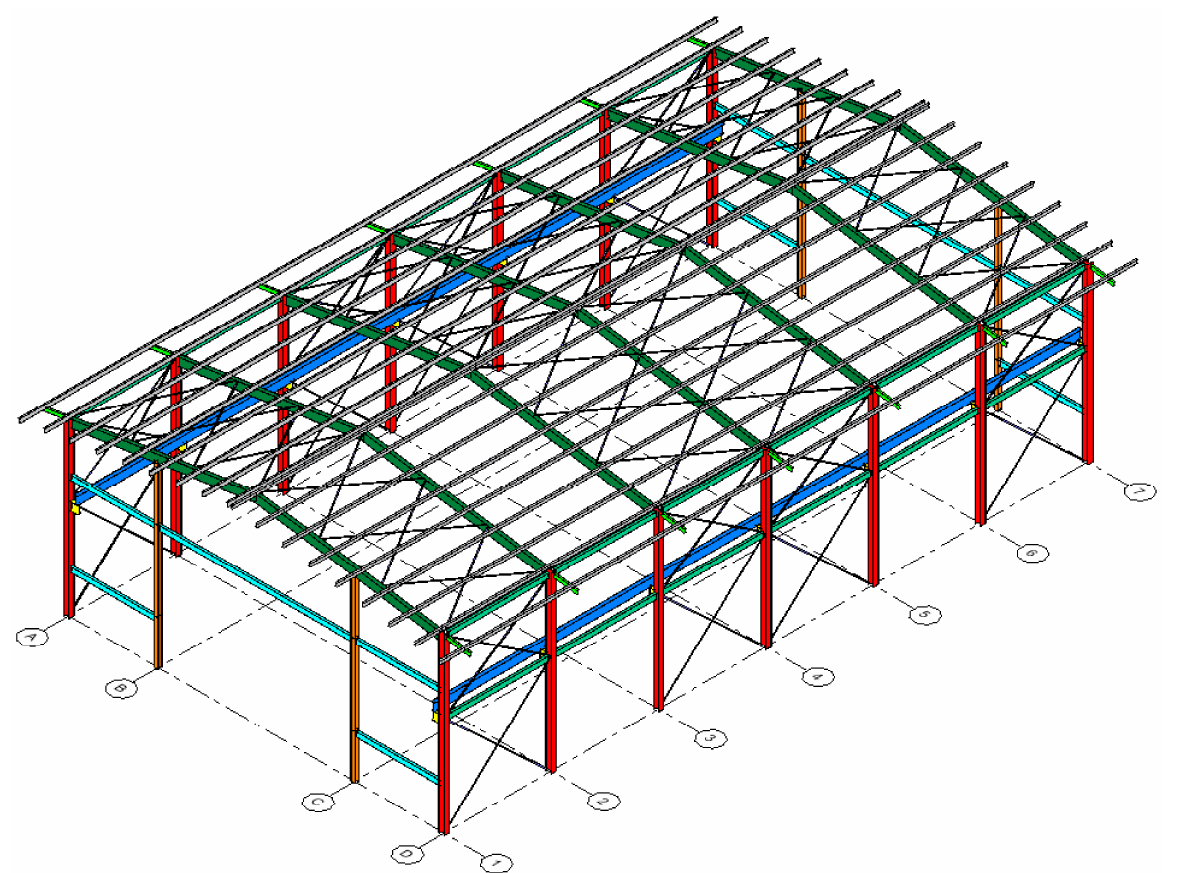
Figure 3. Isometric view of the reference structure. Transverse axis: 1 to 7. Longitudinal axis: A to D. The connection of the overhead crane with the structure is carried out through a pair of crane beams oriented along the longitudinal axis of the warehouse. The crane beams are highlighted in deep blue in Figure 3. The crane loads are applied differently, considering that the hoist loaded to its maximum capacity (100 kN) is completely skewed towards one end, generating a maximum load towards the nearby end and a minimum load towards the far end. These loads have been obtained directly from the manufacturer’s instructions [44], considering the overhead crane’s capacity and the warehouse’s free